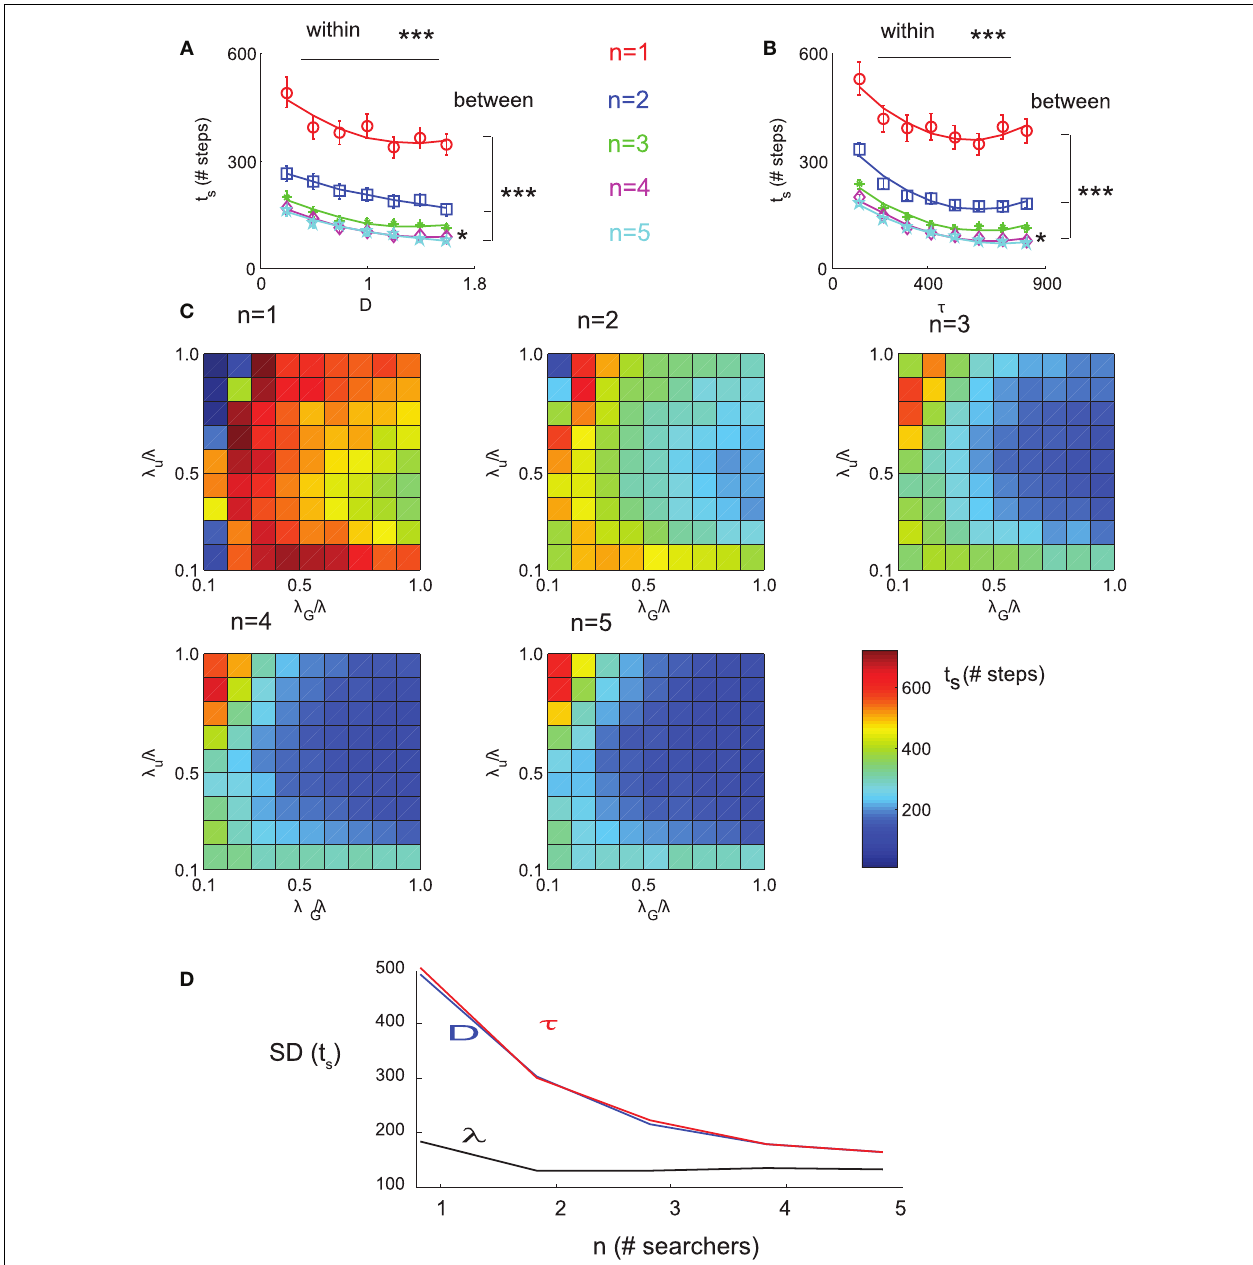
considers a lifetime of particles τ that is different from the one of the source ( τ = 400au). Same conditions as in (A) . (C) Swarm Mapless considers scaling factors λ u and λ G for detection and non-detection events that are different from the correlation length λ of the source. (D) SD of the search time SD ( t s ) versus the number of Mapless searchers n under the three conditions: mismatch in diffusivity D [as in (A) ], mismatch in lifetime of particles τ [as in (B) ] and mismatch in correlation length λ [as in (C)